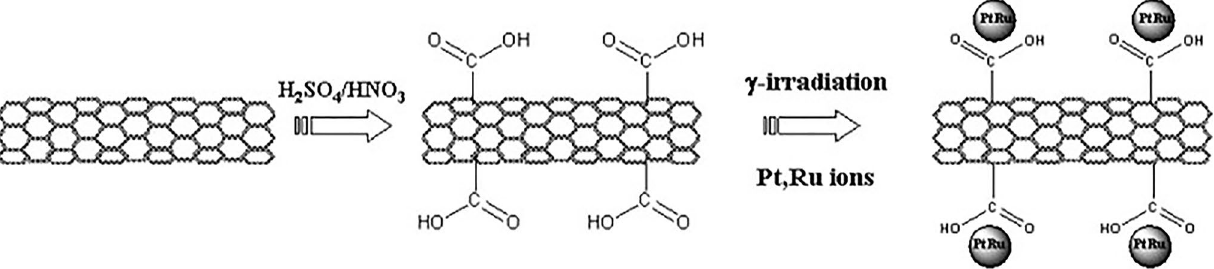
Fig. 5 Surface modification of SWNTs through the presence of characteristic peaks of carboxyl and hydroxyl groups and providing support for the dispersion of Pt-Ru on the surface of